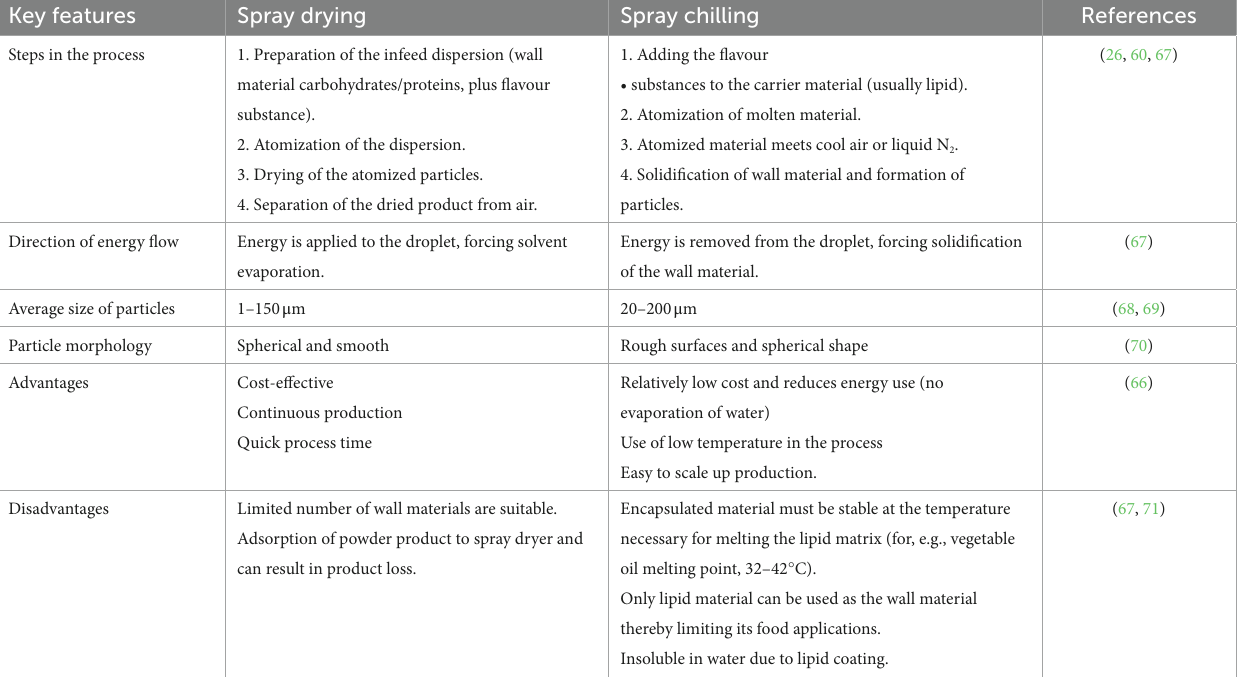
TABLE 1 Key features of spray drying and spray